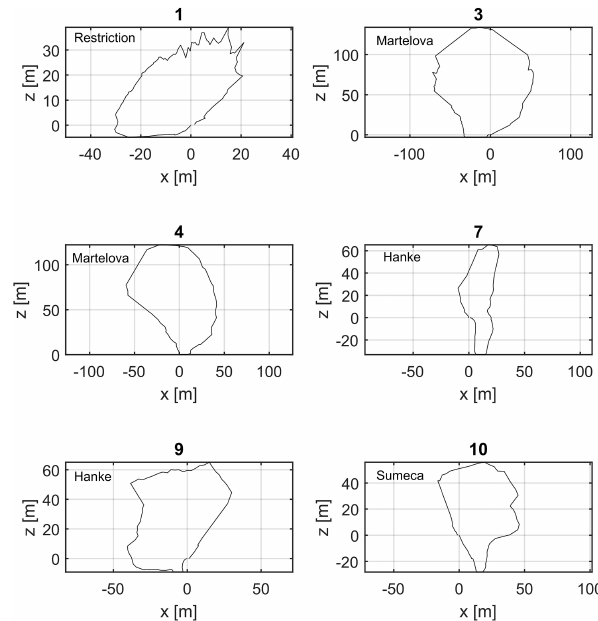
Figure B2. Examples of the cross-section of the cave system; location is labelled in Fig. B1a.